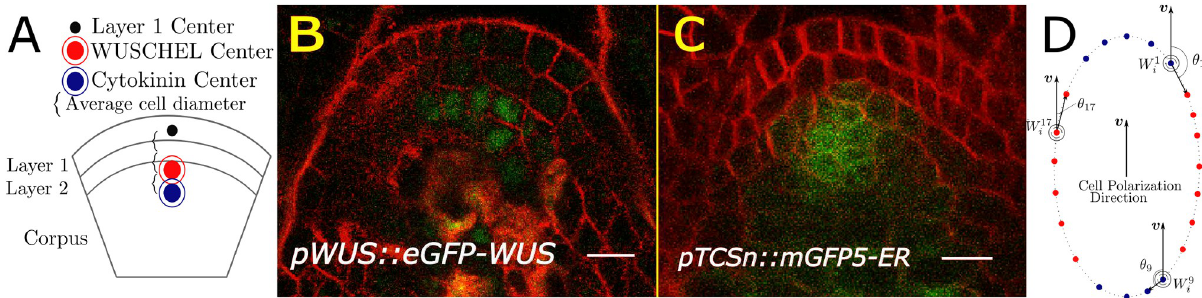
Fig 11. Chemical signaling submodel of the SAM. (A) Schematic of model signal expression domains of WUSCHEL and cytokinin. (B-C) Wildtype SAM longitudinal section image. Cell walls (red) outline the dome-shape of the SAM; reporters (green) indicate presence of the WUSCHEL protein (B) and cytokinin reporter (C). (B-C) Contrast was manually increased in the red channels for visibility. Scale bars are 10 μm . (D) Cell growth direction polarization v is dependent upon signaling. Wall nodes of a model cell polarized in direction v are illustrated. The angle θ j between v and the vector connecting W j to W j þ 1 are used to partition the wall nodes into sides (red) and ends i i